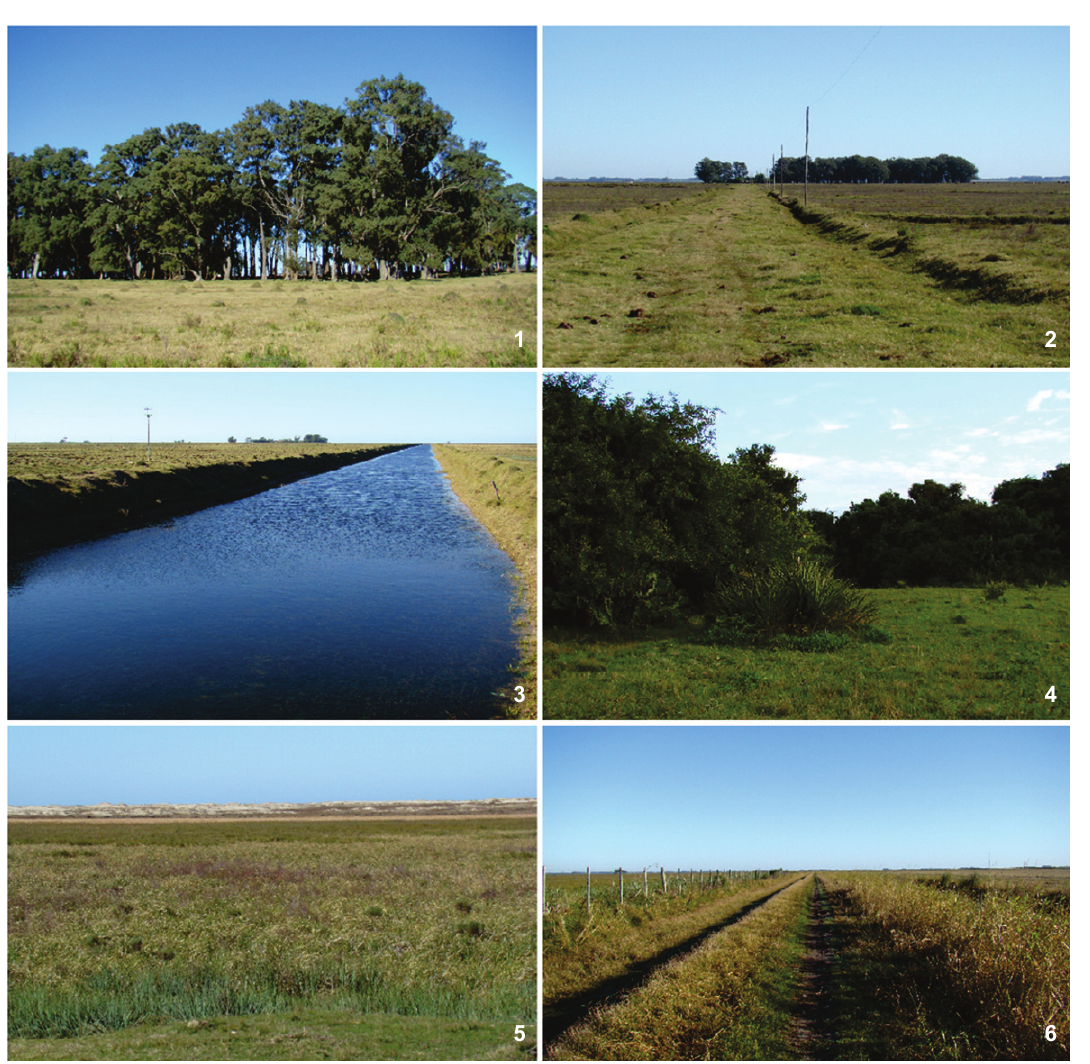
Table I. Transects and habitat types monitored for bat activity with acoustic surveys, from April 2009 to March 2010, in the grasslands of southernmost Brazil. Transect